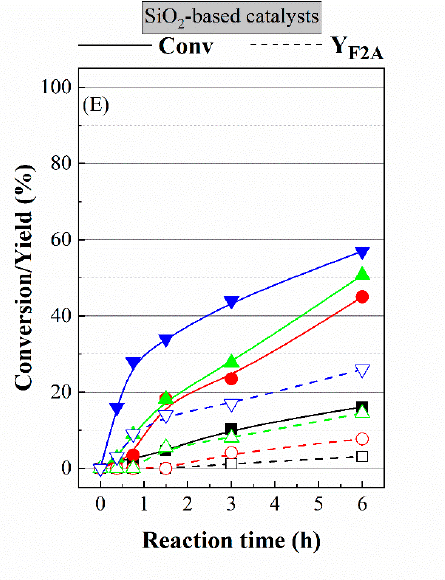
Figure 7. Furfural conversion and F2A yield in the oxidative condensation of FUR using Pd supported on β -zeolite ( A ), Al 2 O 3 ( B ), Fe 2 O 3 ( C ), MgO ( D ), and SiO 2 ( E ). Catalyst without Pd ( ― ), catalyst with 0.5 wt.% of Pd ( ― ), catalyst with 1 wt.% of Pd ( ― ) and catalyst with 2 wt.% of Pd ( ― ). Experimental conditions: temperature: 170 °C; catalyst loading: 0.05 g; V (ethanol): 6 mL; mass of Na 2 CO 3 : 0.10 g; V (H 2 O 2 , 30 wt.%): 0.5 mL.